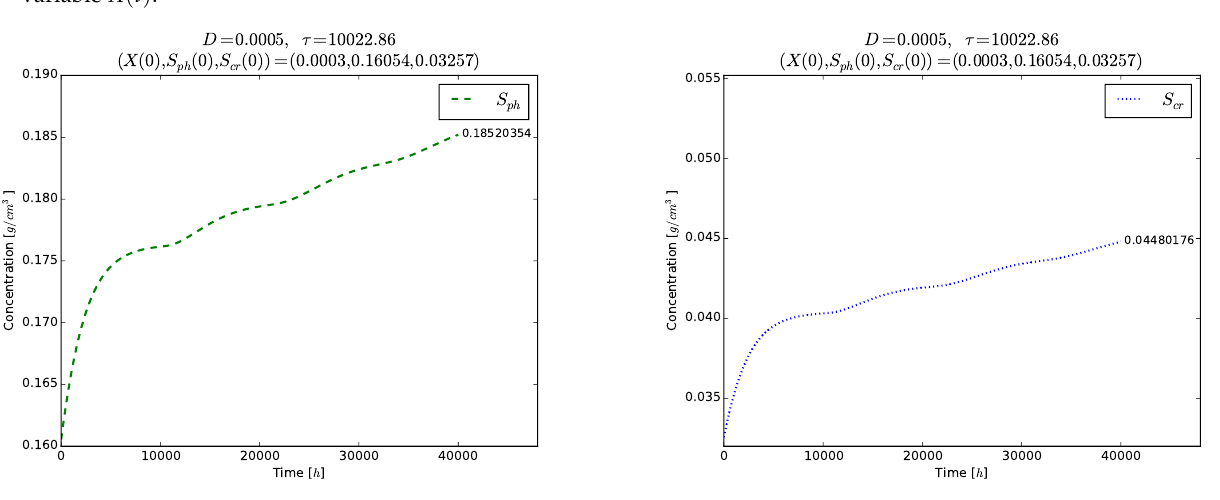
Figure 5. Example 1. Transient oscillations of the phase variables S ph ( t ) ( left ) and S cr ( t ) ( right